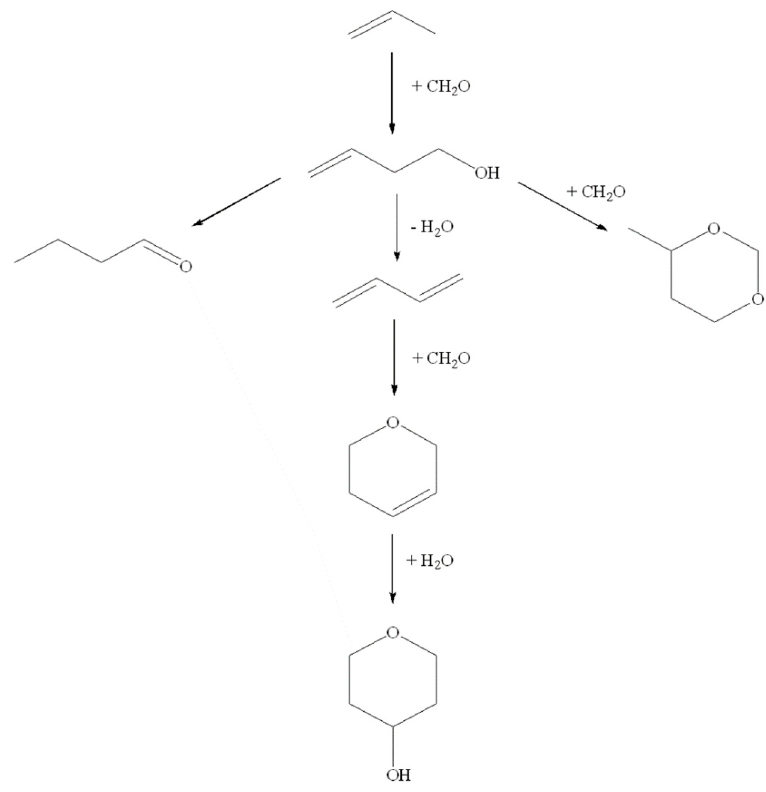
Figure 1. The main reaction network for propylene-formaldehyde condensation.